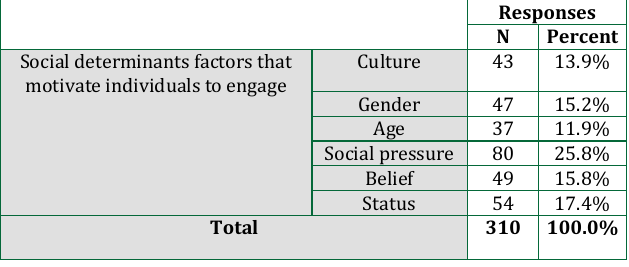
Table 7: Social determinants factors that motivate individuals to engage in cyberbullying on social